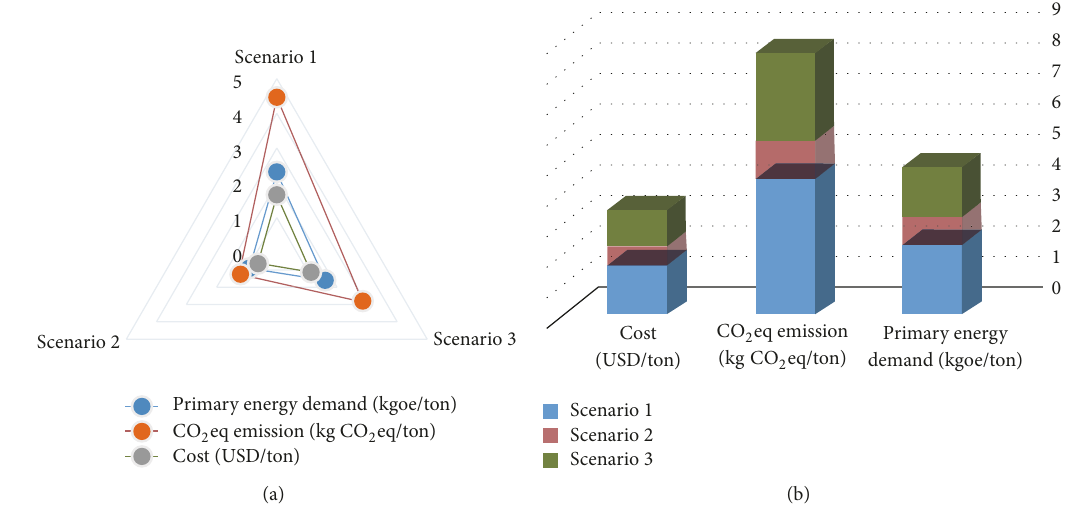
Figure 4: (a) The final status of the three research scenarios. (b) The bar chart of research variables. Table 7: Sensitivity coefficient of the CO 2 emission model to each